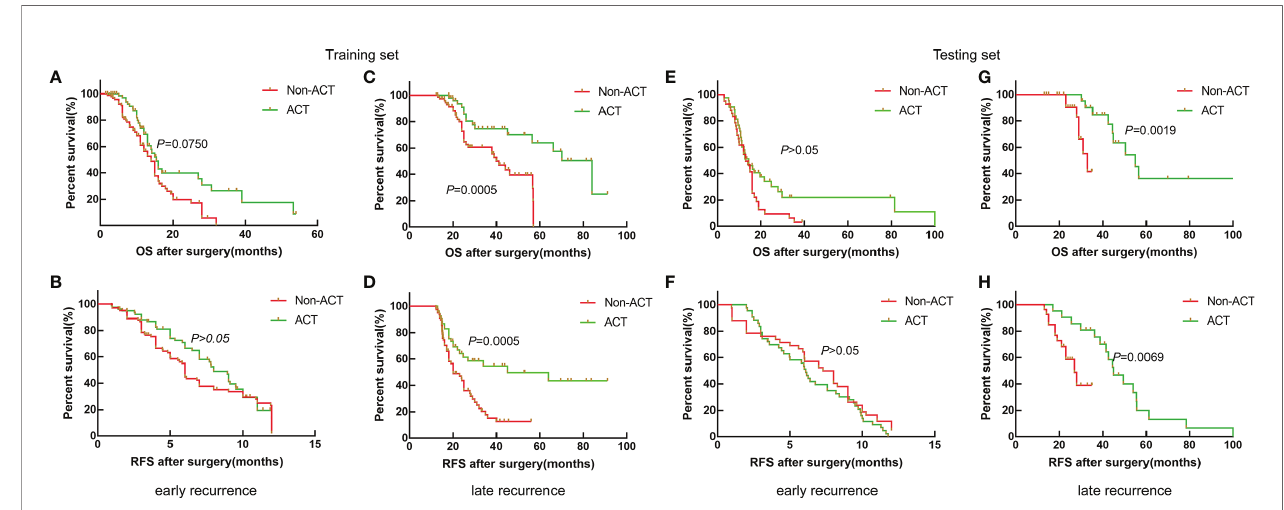
FIGURE 2 | Survival curves of patients with ICC after radical resection between non-ACT and ACT for the early recurrence group and late recurrence group. (A, B) Kaplan – Meier OS curve and RFS curve for the early recurrence group in the training set. (C, D) Kaplan – Meier OS curve and RFS curve for the late recurrence group in the training set. (E, F) Kaplan – Meier OS curve and RFS curve for the early recurrence group in the testing set. (G, H) Kaplan – Meier OS curve and RFS curve for the late recurrence group in the testing